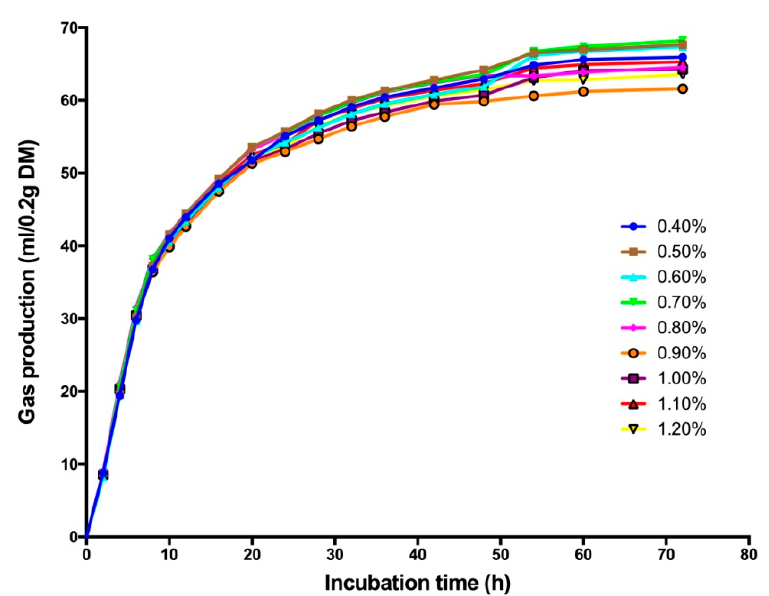
Figure 1. Dynamic changes in the gas production of in vitro ruminal fermentation.